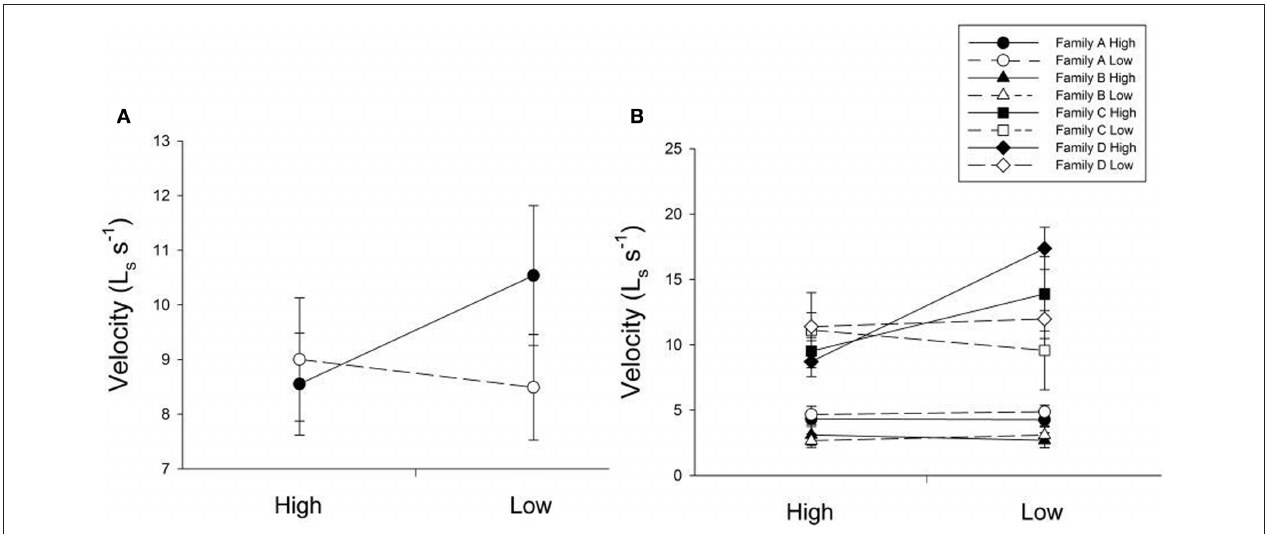
FIGURE 2 | (A) The influence of changing diet ration (constant high, high-to-low, low-to-high, constant low) on swimming velocity across all four treatments. Open lines and symbols represent low food rations days 0–30 and solid lines and symbols represent high food rations for days 0–30. The x-axis represents food ration for days 30–60. Error bars represent standard errors. Diet for days 30–60 (Diet 30 – 60 ) as well as an interaction between both dietary environments (Diet 0 – 30 × Diet 30 – 60 ) were significant sources of variation ( P = 0 . 0199 , 0 . 0143, respectively). (B) The influence of changing